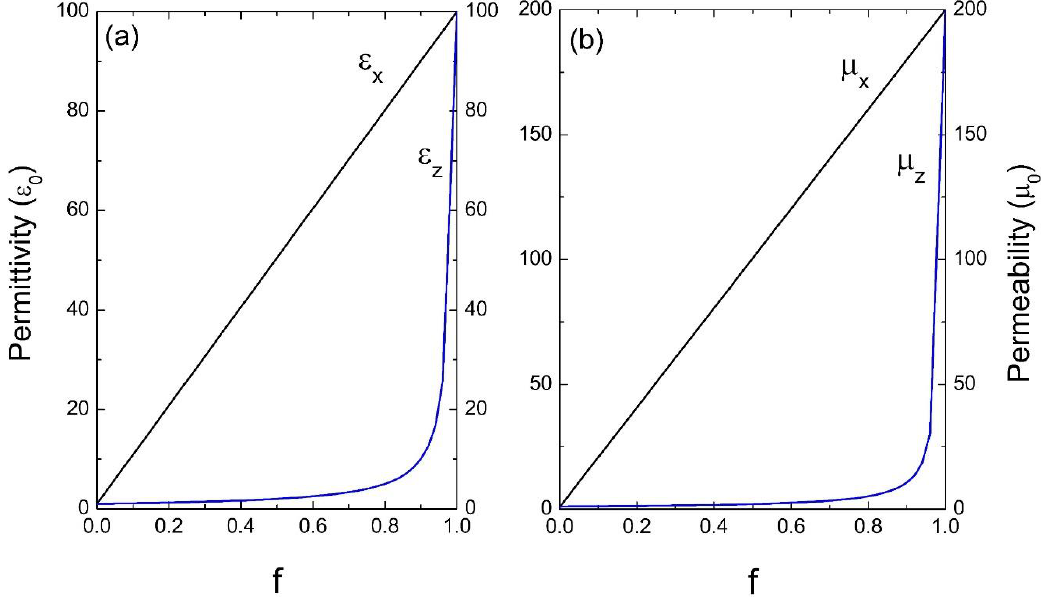
Materials 2020 , 13 , x FOR PEER REVIEW Figure 4. Permittivity ε ( a ) and permeability µ ( b ) versus the filling fraction f ( ε 0 and µ 0 are the units). Figure 4. Permittivity ε ( a ) and permeability μ ( b ) versus the filling fraction f (ε 0 and μ 0 are the units).